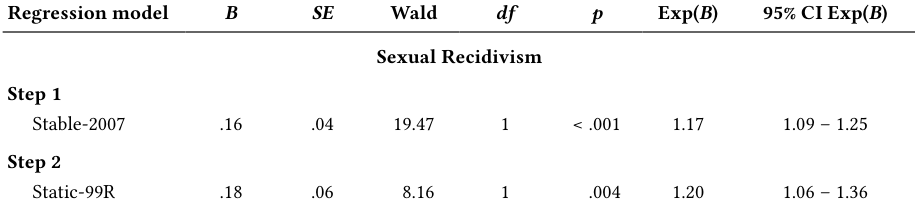
Sample 1: Cox Regression Analysis for Stable-2007 and Recidivism Regression